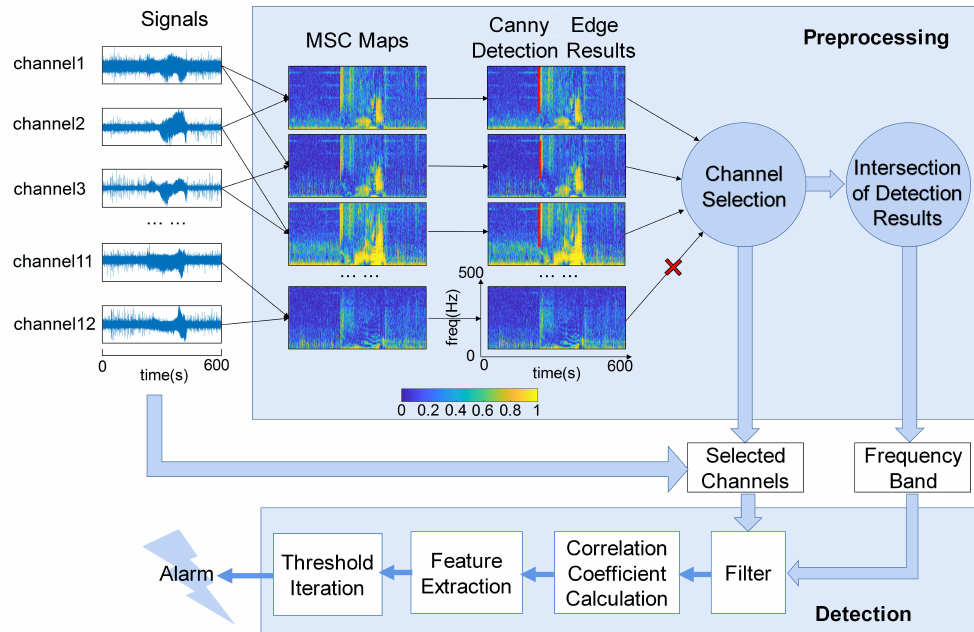
Figure 1. The process of multi-site seizure detection method. The processing is divided into two steps: preprocessing and detection. In preprocessing step, 12-channel signal fragments are first calculated between every two channels to get MSC maps. The edge detection is then performed by the Canny’s edge detection algorithm, and the result is shown as the red line in the figure. Select the original signals of the channel pair with detected edges for subsequent detection. Select the intersection of detection results as the frequency band. In detection step, the selected channels are filtered with the selected frequency band, and the seizure detection is completed through the steps of correlation coefficient calculation, feature extraction and threshold